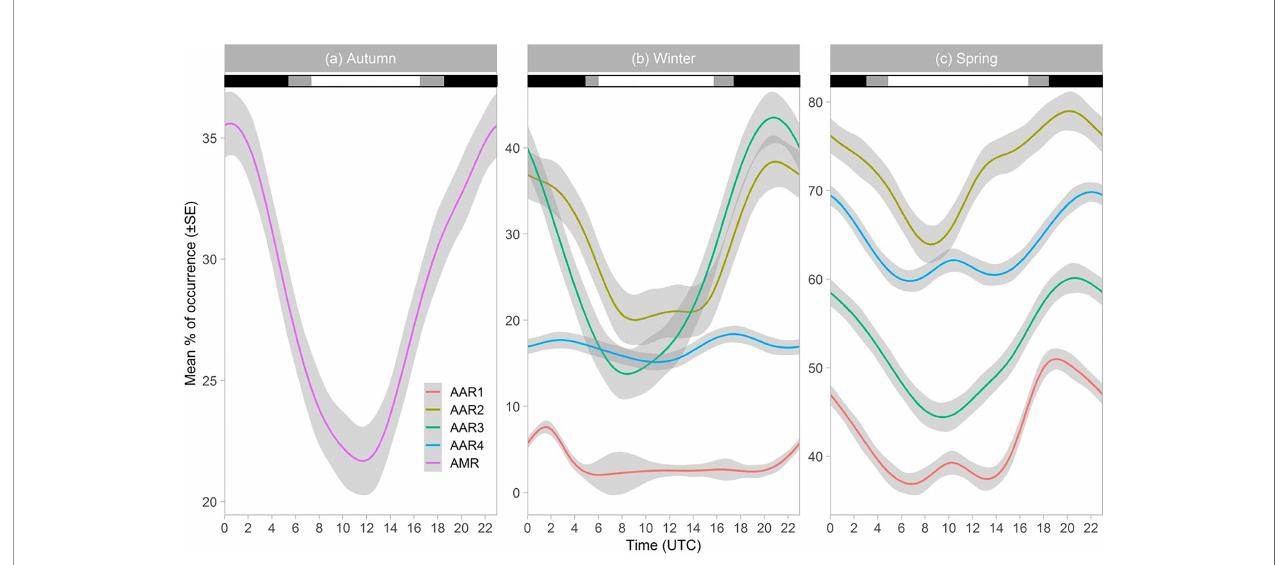
FIGURE 4 | Diel percentage of acoustic occurrence per season for humpback whales off the west coast of South Africa (AARs 1, 2, 3 and 4) and Maud Rise, Antarctica (AMR). Note different y-axes scales. Horizontal bar shadings indicate daylight regime: black represents the average nighttime hours; grey represents average twilight hours; white represents average daytime hours. Grey shading around line plots indicates the standard error (SE). Autumn daylight regime is from the Maud Rise since there was no pattern for South African waters, and remaining daylight regimes are from South African waters since there was no presence data for the Maud Rise. Coordinated Universal Time (UTC) is used.